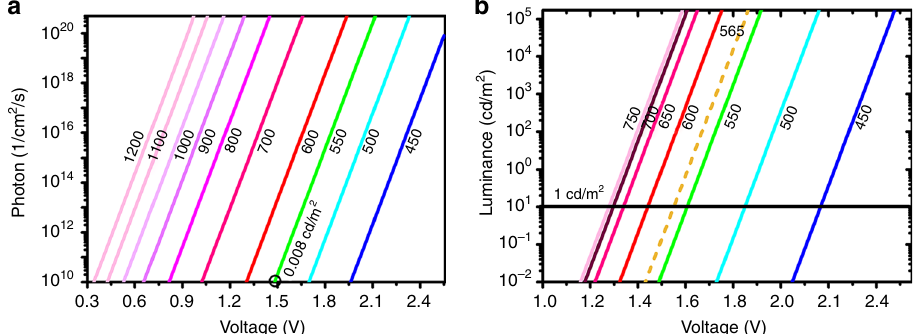
Fig. 1 Calculated emission intensity. The photon current density ( a ) and luminance ( b ) as a function of voltage for various color OLEDs. 10 10 photon/cm 2 /s @550nm corresponds to 0.008 cd/m 2 . The short-dashed line in b is for rubrene emission with peak of 565 nm. The black line is guide for eyes of 1 cd/m